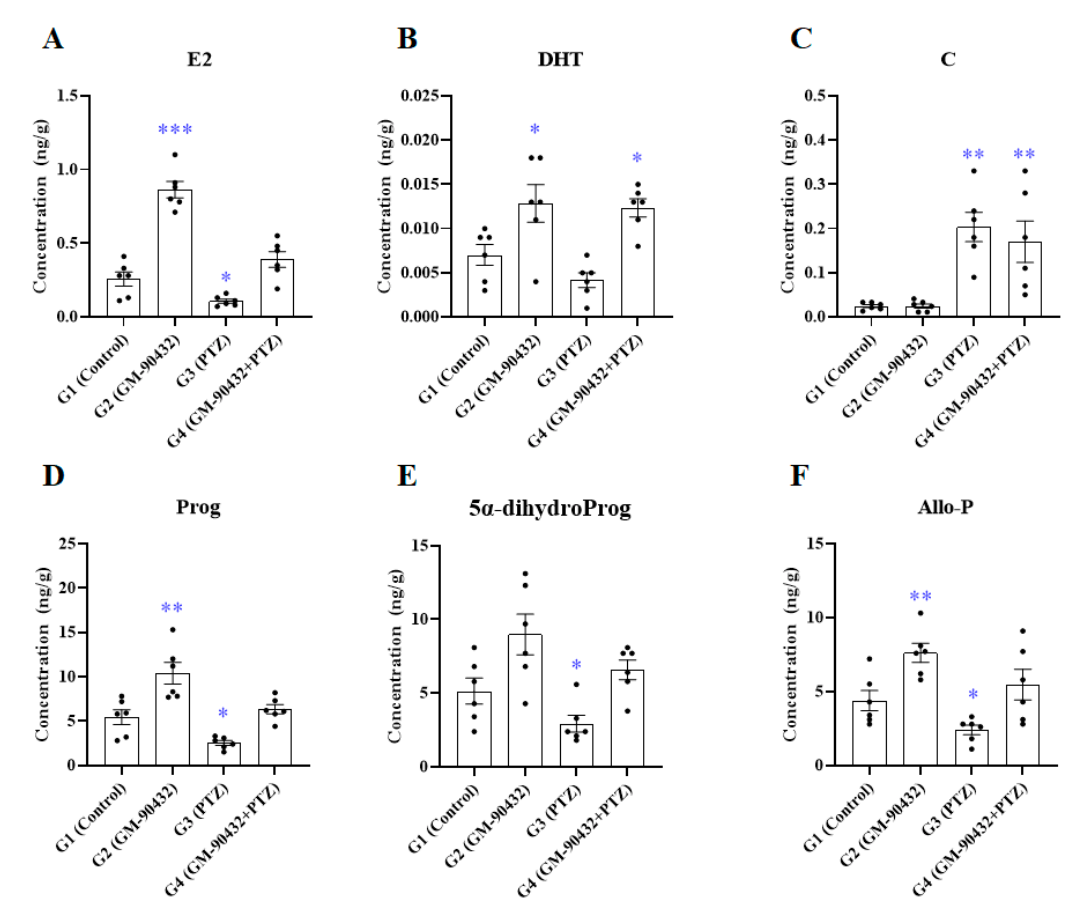
Figure 3. The levels of E2 ( A ), DHT ( B ), C ( C ), Prog ( D ), 5 α -dihydroProg ( E ), and Allo-P ( F ) in brain samples of zebrafish exposed to GM-90432, PTZ, or PTZ following pretreatment with GM-90432. Values represent means ± SEM of 6 samples. The brain samples from 2 individual zebrafish were pooled to form composite samples. Significance between control and exposure groups is indicated by * p < 0.05, ** p < 0.01, and *** p < 0.001.